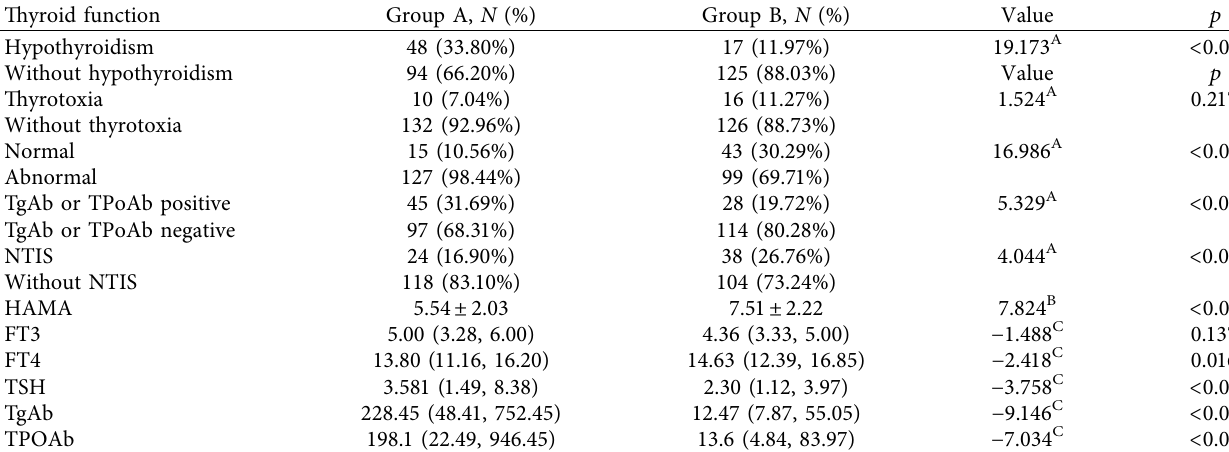
Table 3: Comparison of thyroid function between Group A and Group B without thyroid disease.